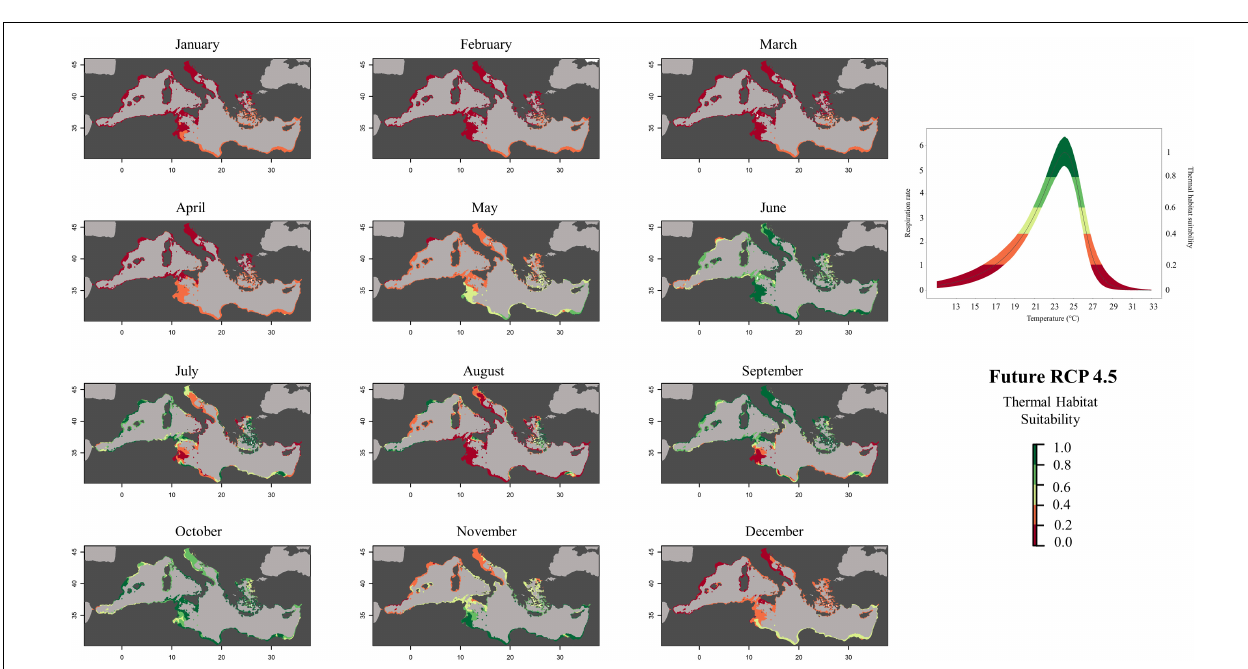
FIGURE 5 | Future (RCP 4.5, 2050) predicted habitat suitability probability of Pennaria disticha based on respiration rate values (mg h – 1 g – 1